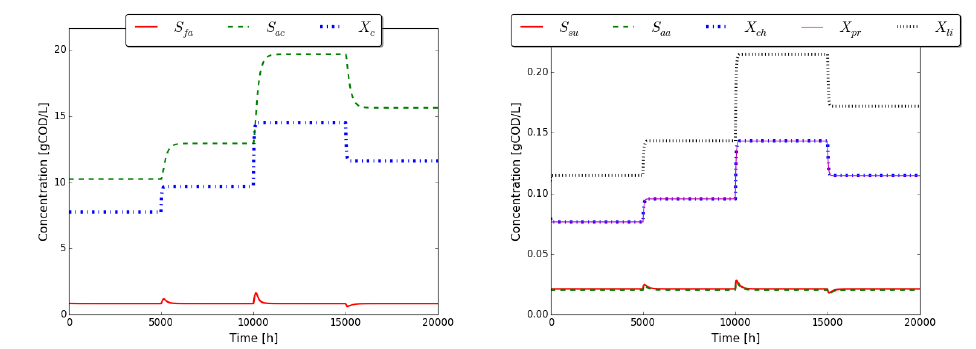
Figure 11. Dynamic behavior of the model solutions with variable X in c from Table 4.